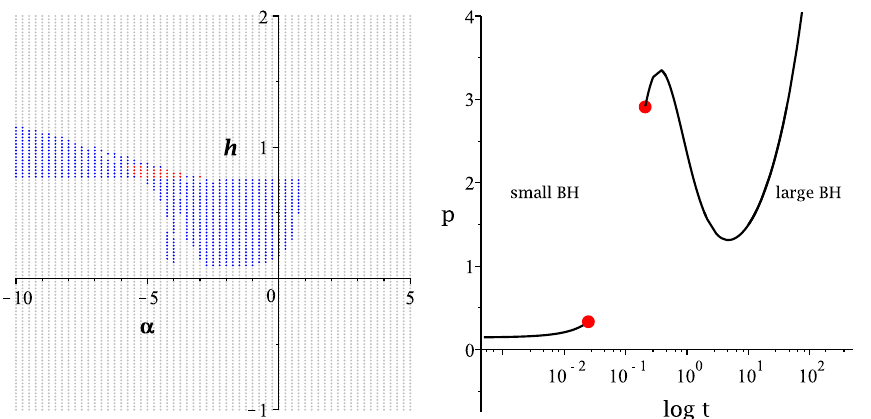
Figure 6 . Hyperbolic black holes without charge: Left : critical point pro(cid:12)le for (cid:15) = (cid:0) 1, k = (cid:0) 1 with q = 0. In producing this plot, the only points included are those which satisfy all physicality conditions and also occur at a minimum of the Gibbs free energy. Here red, blue, and grey points indicate two, one, and zero critical points, respectively. Right : representative phase behaviour for the region with two critical points, shown here for (cid:11) = (cid:0) 5 with h = 0 : 825. Here the two solid, red dots indicate critical points, while the solid black curves mark (cid:12)rst order coexistence lines. Here we see an example of a small/large/small/large black hole reentrant phase transition for p in the approximate range 2 : 8 to 3 : 3 as temperature is increased monotonically.